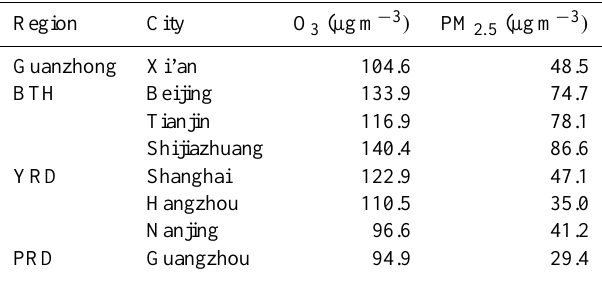
Table 2. Summertime O 3 and PM 2 . 5 concentrations (averaged in the afternoon) in the main cities of Guanzhong basin, BTH, YRD, and PRD in China during 2013.